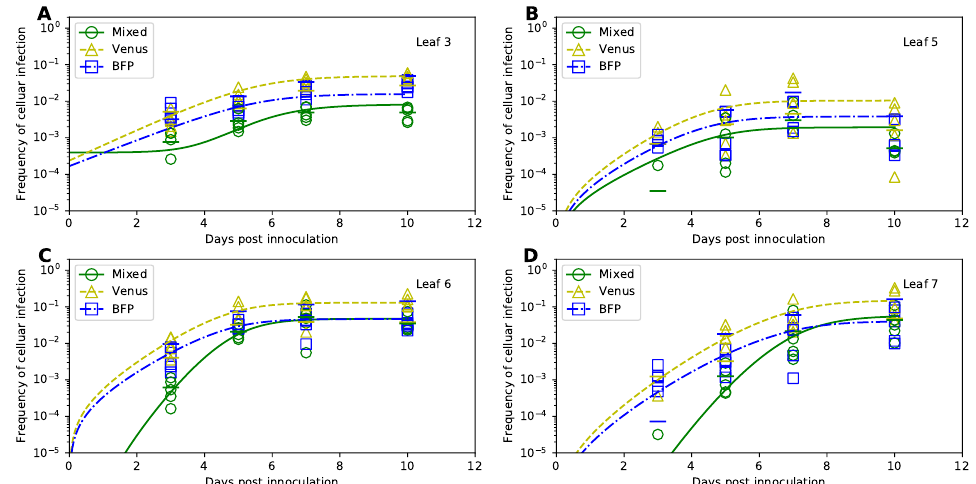
Figure 6. The 2-alpha probabilistic model fits the coinfection data with best quality. The 2-alpha probabilistic model (Equations (18), (19) and (25)) assumes that coinfection of individual cells by two different strains depends on the level of uninfected cells in the leaf ( S k ) and that local coinfections in the leaf occur at different kinetics that coinfection between leaves (Figure 2B). We fitted this model to the data on infection of cells by either individual viruses or coinfection of the same cell by different viruses. The model was fitted using the binomial distribution-based likelihood method (Equation (29)). Markers show frequency of cells infected with Venus or BFP viruses or coinfected with both viruses (“Mixed”), and lines are predictions of the mathematical model for leaf 3 ( A ), leaf 5 ( B ), leaf 6 ( C ), and leaf 7 ( D ). The short horizontal bars show the average infection rate for a given virus variant for a particular day and infected cell type. The parameters providing the best fit and their 95% confidence intervals (estimated using by boostrapping the data) are as follows: V 0 = 0.0002 ( 2 · 10 − 5 ,0.001 ) , B = 0.0002 ( 2 · 10 − 8 ,0.001 ) , M = 0.0008 ( 0.0,0.001 ) , β = 0.975 ( 0.606,10 ) /day, V 0 0 β B = 0.835 ( 0.426,10 ) /day, χ 5 = 0.116 ( 0.004,9.522 ) /day, χ 6 = 0.858 ( 0.0001,10 ) /day, χ 7 = 0.031 ( 0.0001,10 ) /day, ψ 3 = 0.073 ( 0.040,0.118 ) , ψ 5 = 0.016 ( 0.003,0.260 ) , ψ 6 = 0.223 ( 0.124,0.260 ) , ψ 7 = 0.247 ( 0.067,0.400 ) , α 1 = 10.120 ( 3.686,16.275 ) , α 2 = 0.814 ( 0,20 )